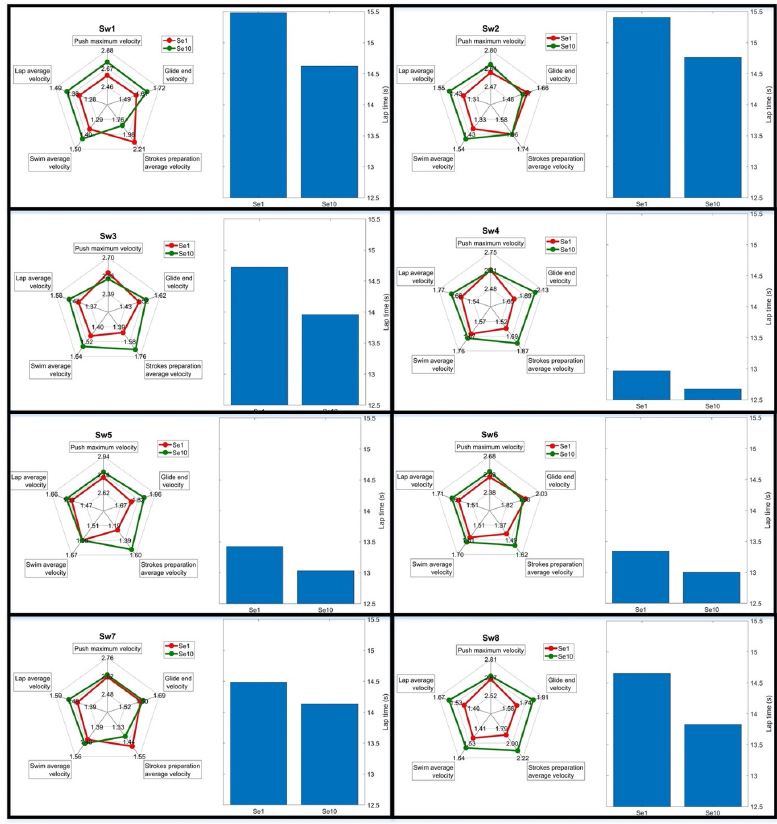
Figure A1. Average values of goal metrics and lap times in first (Se1) and last (Se10) session for the swimmers of the experimental group.